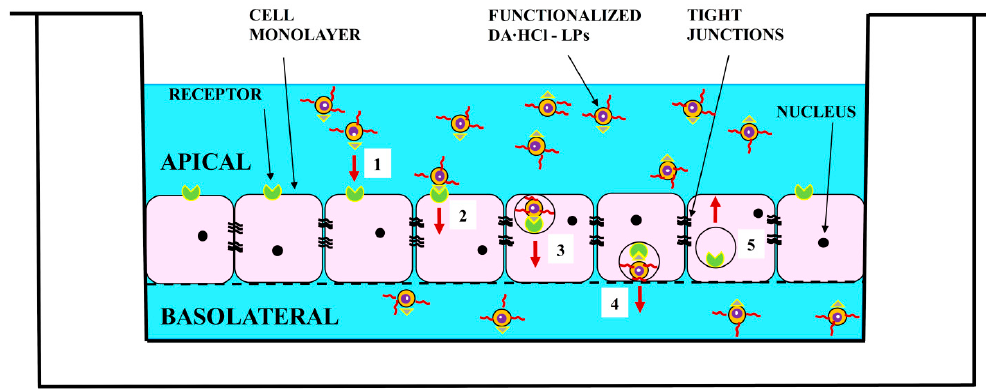
Figure 4. Representation of the endogenous Tf receptor-mediated transcytosis of DA ∙ HCl loaded Tf functionalized LPs across an in vitro model of human BBB composed of hCMEC/D3 cell monolayers.